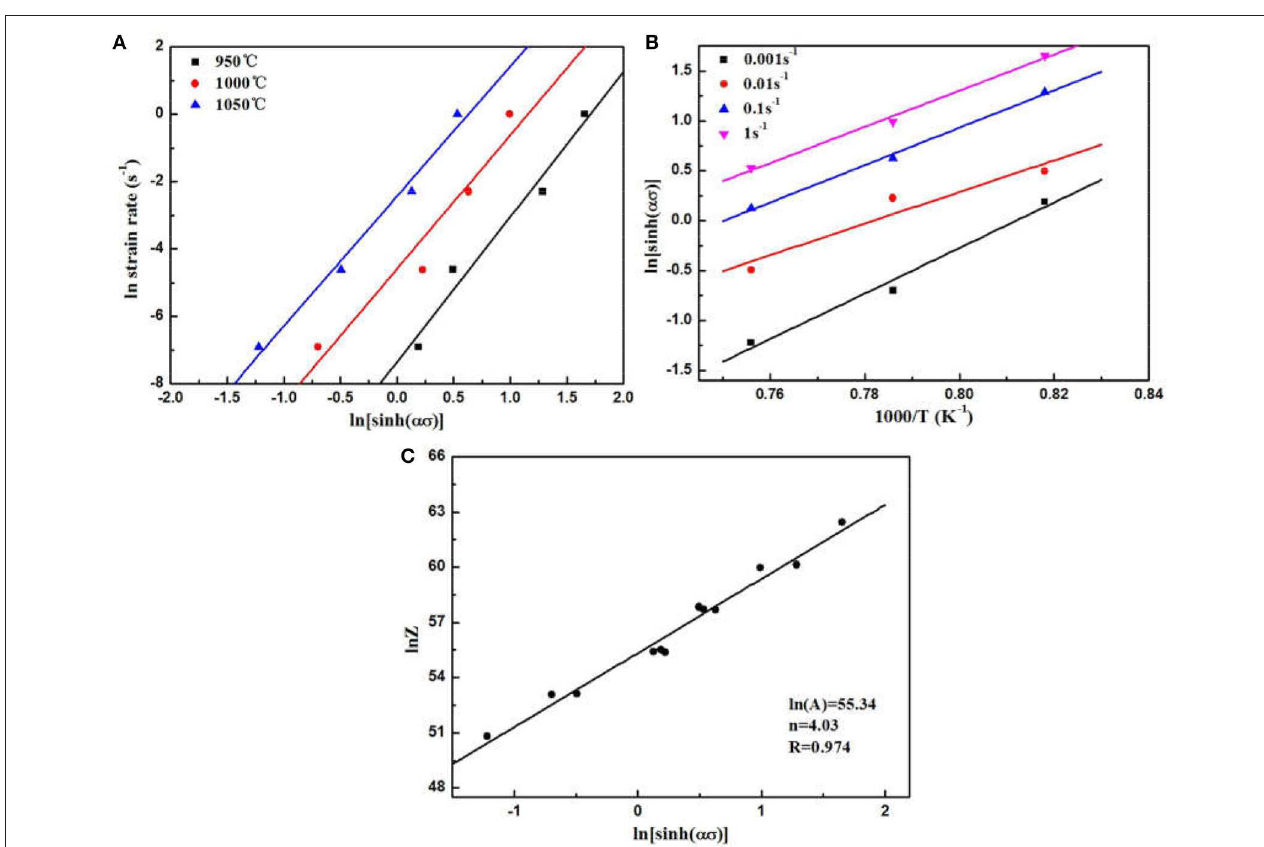
FIGURE 5 | Variation of the peak flow stress for the Ti-25.5Al-13.5Nb-2.8Mo-1.8Fe alloy: (A) ln(sinh ασ ) vs. ln ˙ ε ; (B) ln(sinh ασ ) vs. 1,000 / T ; (C) ln(sinh ασ ) vs. ln Z .